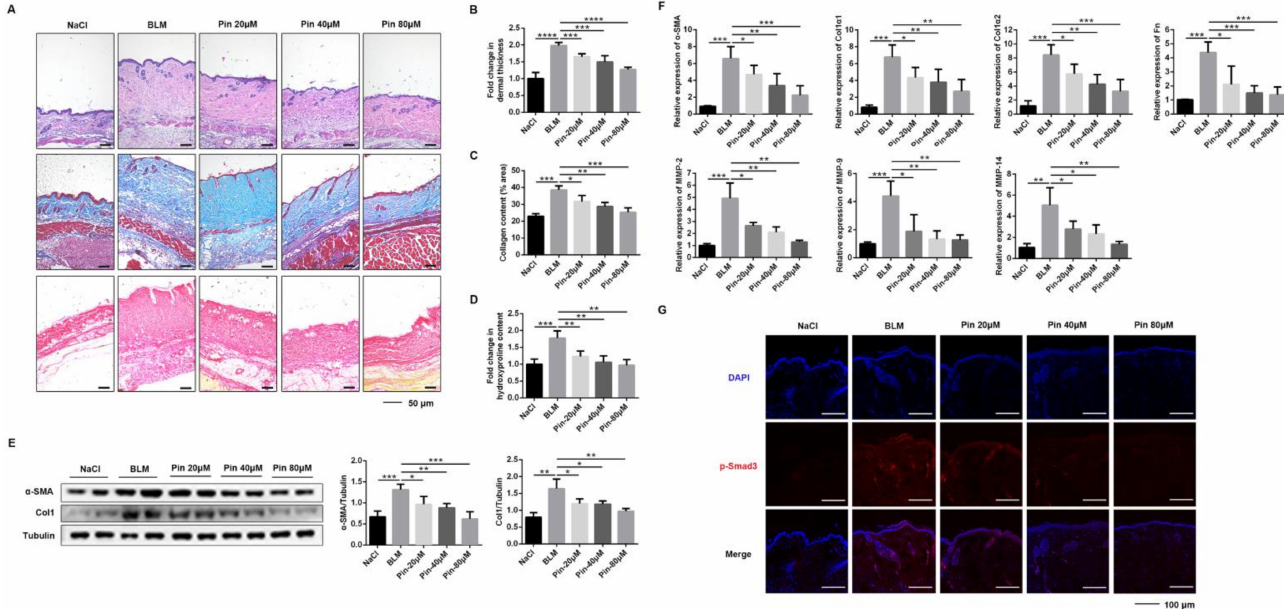
Figure 5. Pinocembrin ameliorates BLM-induced skin fibrosis in mice. ( A ) Representative skin sections stained with hematoxylin–eosin (H&E), Masson’s trichrome, and Sirius red staining ( × 100, Scale bar = 50 µ m). ( B ) Total dermal thickness of the back of each group of mice. ( C ) Collagen density was quantified on Masson’s trichrome images. ( D ) Hydroxyproline content of skin tissues in mice. ( E ) Protein levels of α -SMA and Col1 were verified by Western blot in the lesional skin. ( F ) mRNA levels of α -SMA, Col1 α 1, Col1 α 2, Fn, MMP-2, MMP-9, and MMP-14 in the lesional skin were assessed by qPCR. ( G ) Immunofluorescence staining of p-Smad3 in skin frozen sections of BLM-induced model ( × 400, Scale bar = 100 µ m). Means ± SD, n = 8. * p < 0.05, ** p < 0.01, *** p < 0.001, **** p <